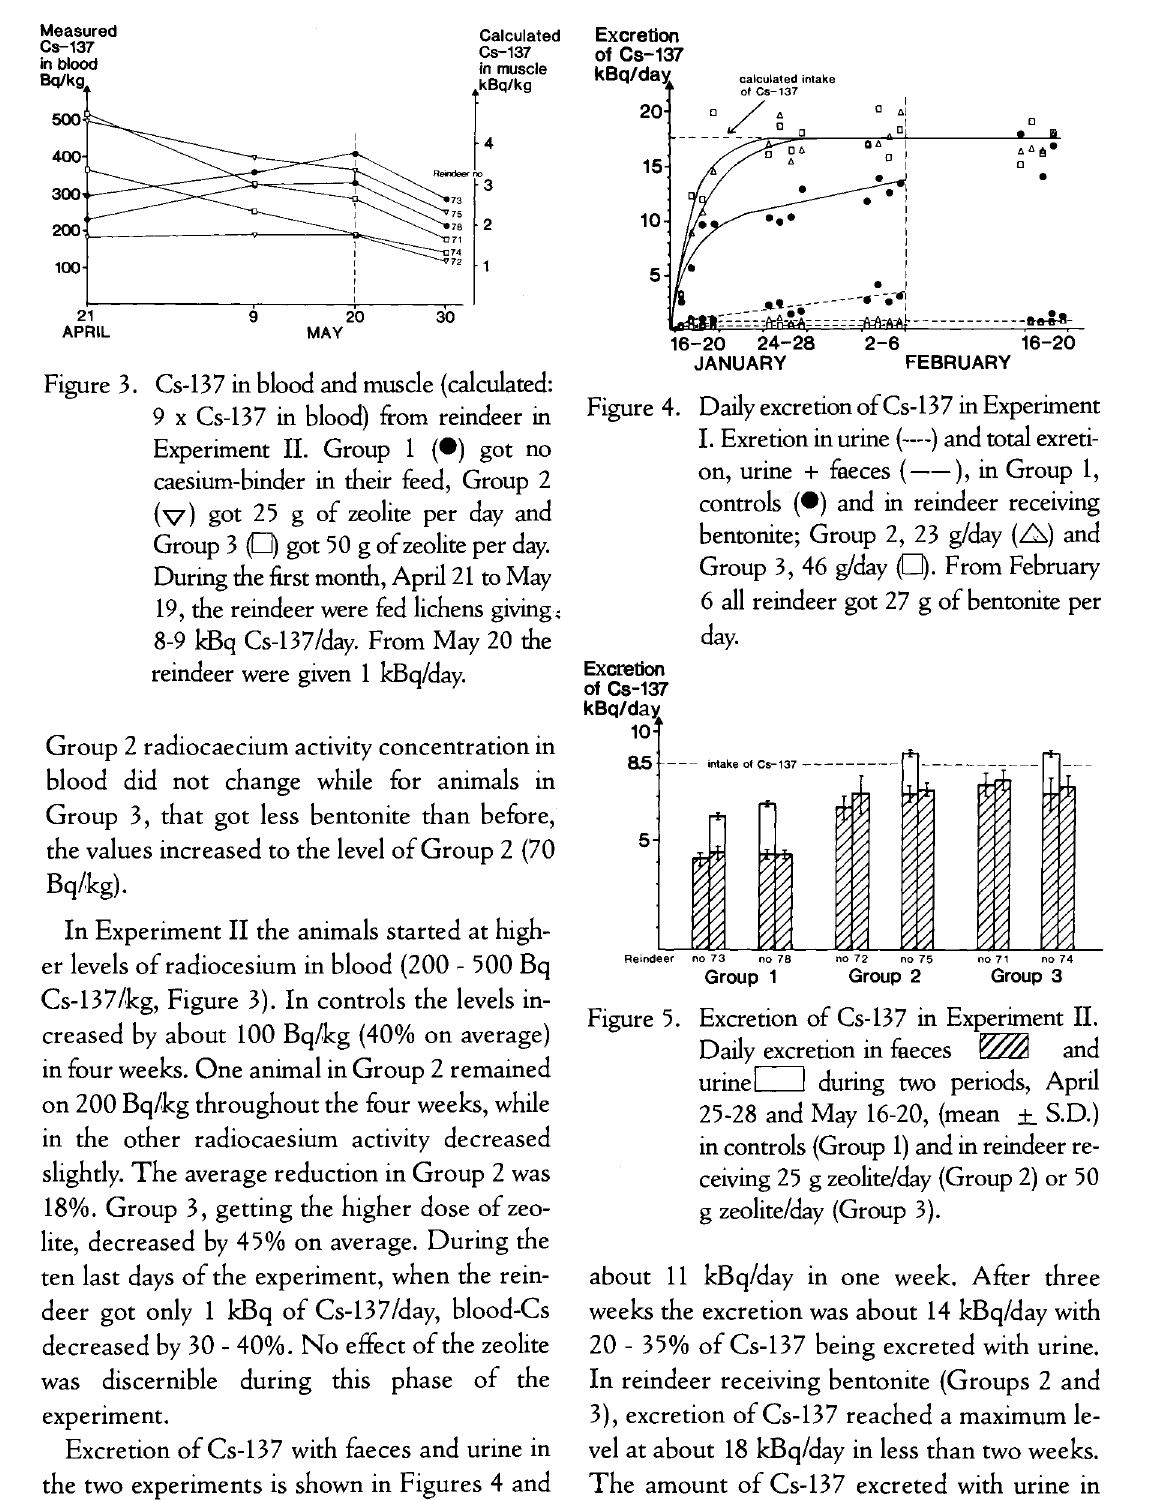
Figure 3. Cs-137 in blood and muscle (calculated: 9 x Cs-137 in blood) from reindeer in Experiment II. Group 1 (•) got no caesium-binder in their feed, Group 2 (v) g ot 25 g of zeolite per day and Group 3 (•) got 50 g of zeolite per day.